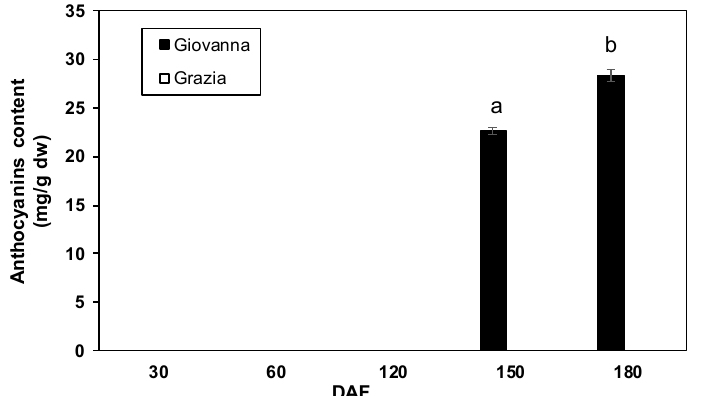
Figure 3. Total anthocyanin content at different development stages of “Giovanna” (dark-blue) and “Grazia” (white) fruit. Error bars represent the standard error of the mean of three biological replicates. Every replication consisted of 40 berries. Different letters represent statistically significant differences with Tukey’s B-test ( p < 0.05). Tukey’s B-test was carried out by comparing all means calculated at different DAFs for both cultivars.